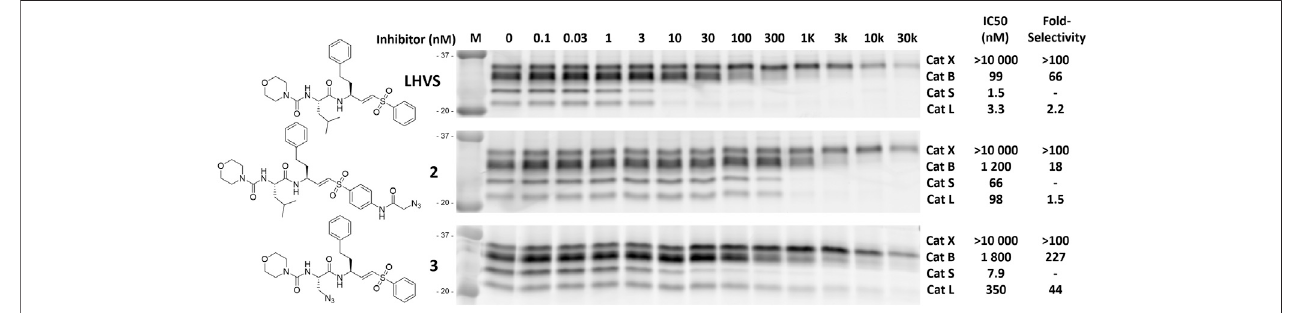
FIGURE 2 | Competitive labeling of LHVS derivatives. Live RAW macrophages were incubated with the indicated concentration of inhibitor for 1 h after which the residualcathepsinactivitywaslabeledwithBMV109.Thecellswerelyzed,separatedbySDSPAGEandthelabelingintensitywasquanti fi ed.IC50sandselectivityforCat S were calculated and are presented in the adjacent table. Experiments were performed in